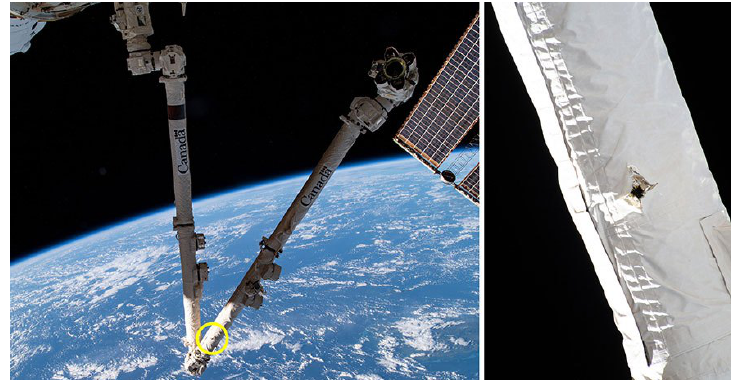
Figure 1. Damage on Canadarm2 [2].